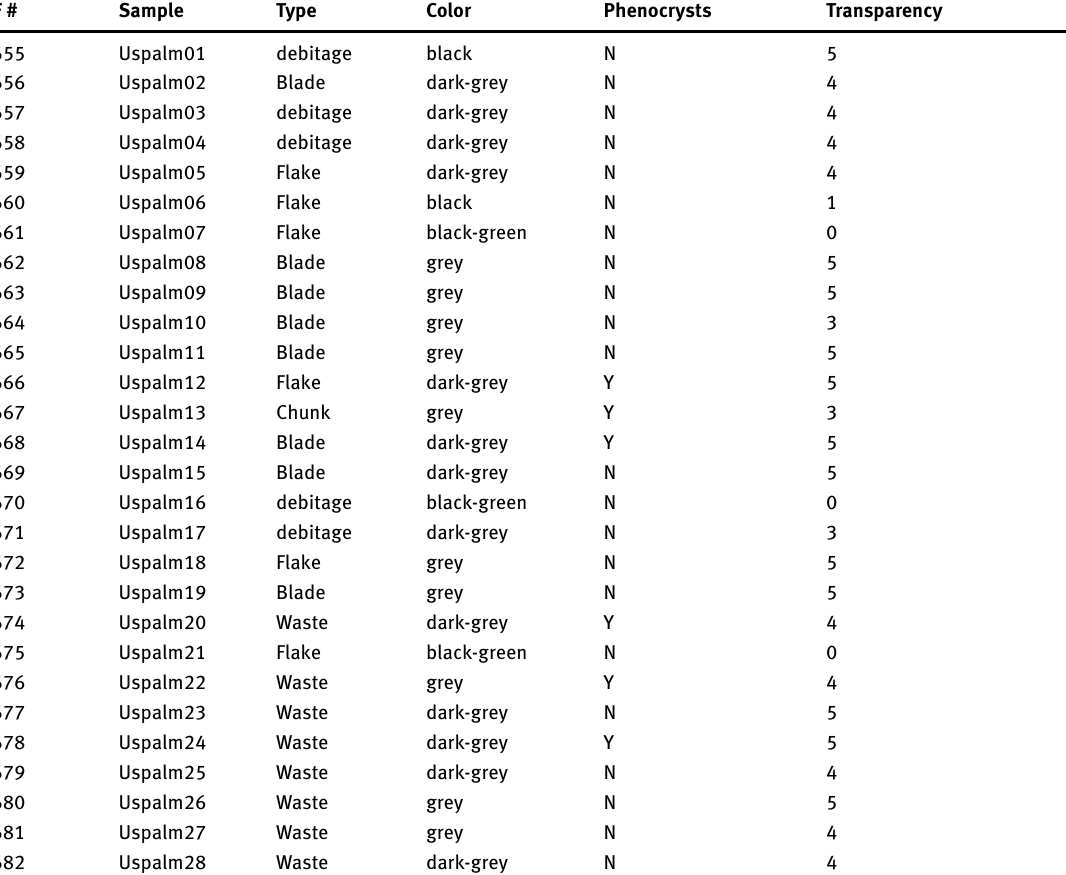
Table 1. Visual characteristics of the Pirozza-Spalmatore obsidian artifacts (the transparency index is expressed in a scale from 0 to